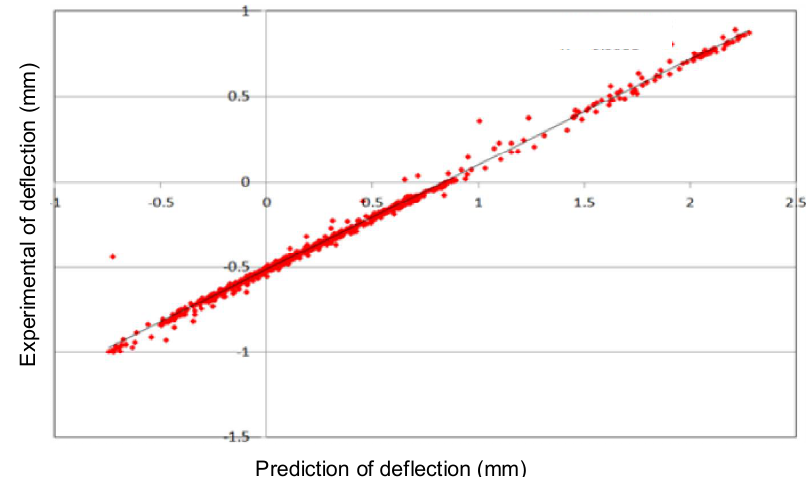
Figure 11. Predicting the accuracy of neural-network system for no-fines lightweight concrete wall with the horizontal reinforcement.